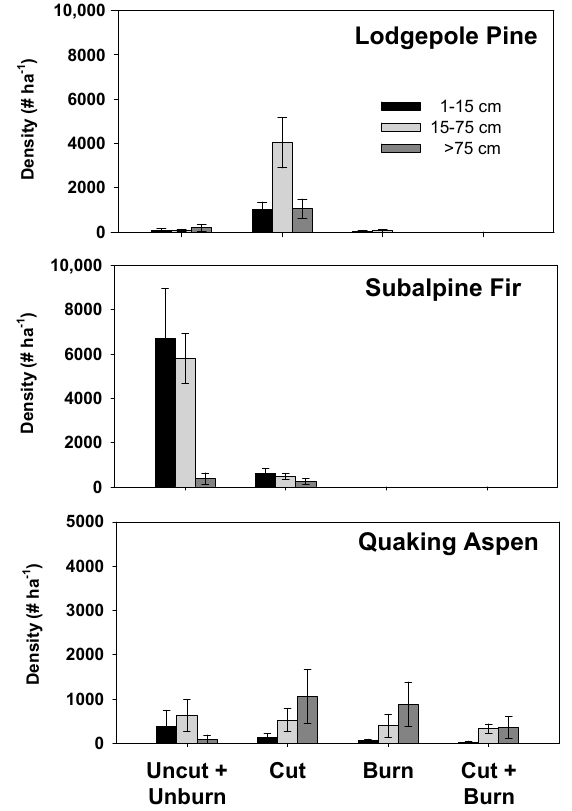
Figure 3. Tree seedling density in August 2014, four growing seasons after the Church’s Park Fire and five years after harvesting of the bark beetle-infested lodgepole pine overstory. Data are means with standard error bars for twelve stand-scale sampling areas per ecosystem condition, by seedling height class. Spruce seedlings were absent from both burned conditions (Burn and Cut + Burn) and represented <56 tree ha − 1 in both unburned conditions (Unburn + Uncut and Cut). Note: The y axis of the bottom panel is half that of the upper two panels.